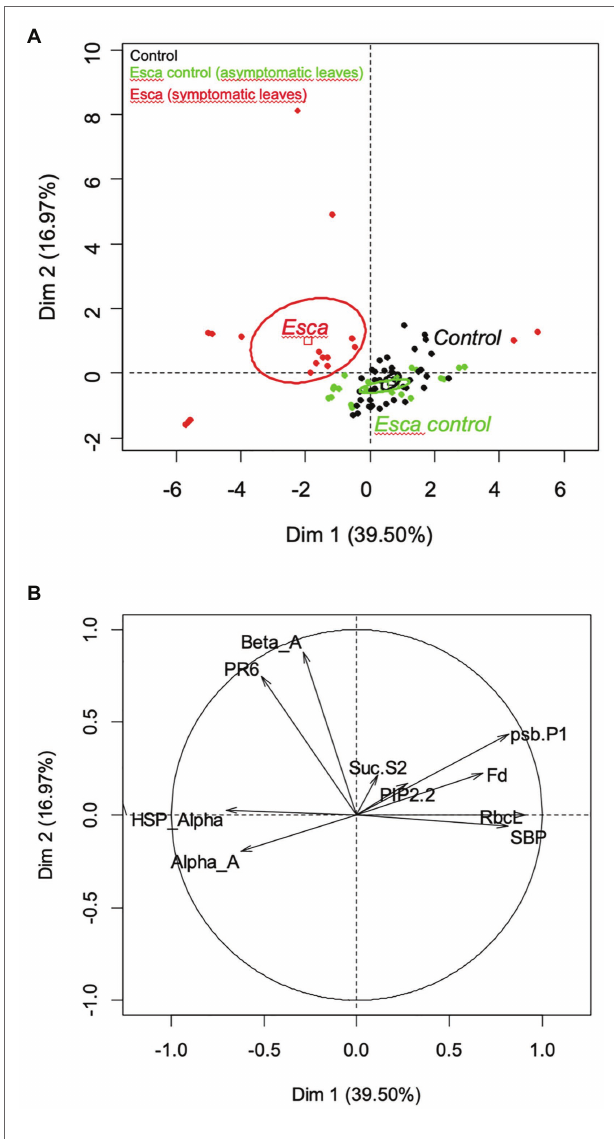
FIGURE 9 | Principal component analysis (PCA) for the quantitative reverse transcription (RT-qPCR) results, showing (A) the confidence ellipses for control (black), Esca-asymptomatic (green), and Esca-symptomatic (red) leaf samples, and (B) the correlation circle with the two axes of PCA performed for control, Esca-asymptomatic, and Esca-symptomatic leaf